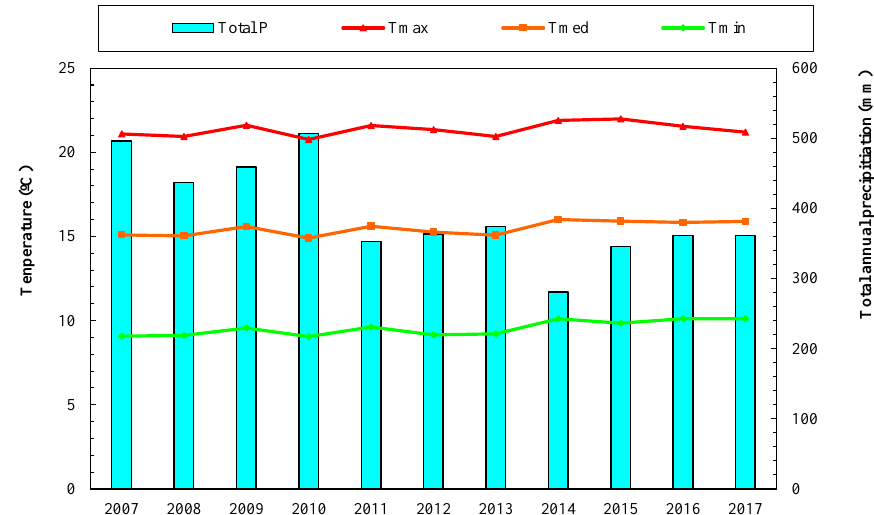
Figure 2. Annual precipitation (total P, mm) as well as mean maximum, average and minimum air temperatures (T max , T med and T min ) in the study area (Villamalea, Castilla La Mancha, SE Spain). According to FAO-UNESCO [36] and the IUSS Working Group WRB [37], the soils of the study area are classified as Calcic cambisols . Organic matter content is on average 1.1 g/m 3 , varying from 1.05 – 1.12 g/m 3 . The texture is sandy clay loam (60% sand, 10% silt, and 27% clay) over a limestone parent material.